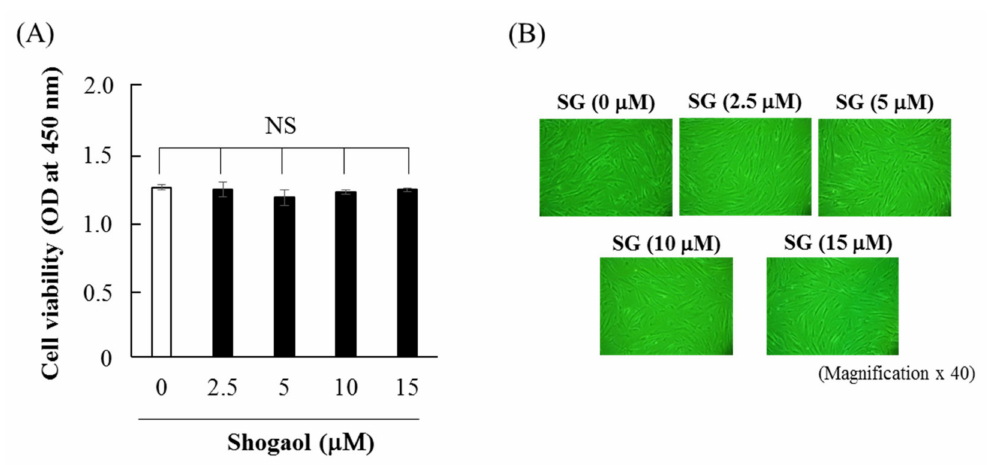
Figure 1. E ff ects of 6-shogaol on cell viability and the morphology of HGFs. HGFs were seeded at 4800 cells / cm 2 , cultured for 5 days, and then treated with 6-shogaol (2.5–15 µ M) for 48 h. ( A ) Cell viability was assessed using Cell Counting Kit-8 ® . Data are expressed as the mean ± SD of 4 independent experiments. NS indicates no significant di ff erence between the indicated groups. ( B ) Cultured HGFs were observed using phase-contrast microscopy after culture with 2.5–15 µ M 6-shogaol for 48 h. (Magnification ×